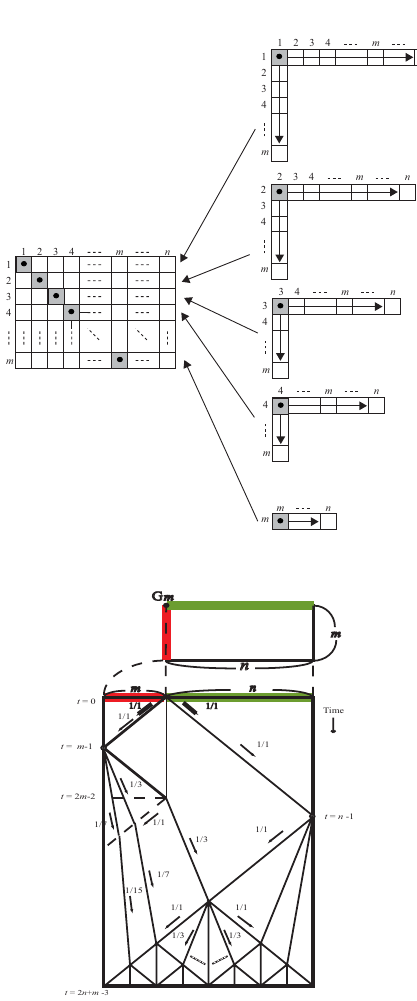
Fig. 2. L-shaped decomposition of an m × n rectangle cellular automaton and a space-time diagram for the L-shaped base syn- chronization algorithm. A black circle • in a shaded small square represents a general on each L i and a wake-up signal for the synchronization generated by the general is indicated by a horizontal and vertical